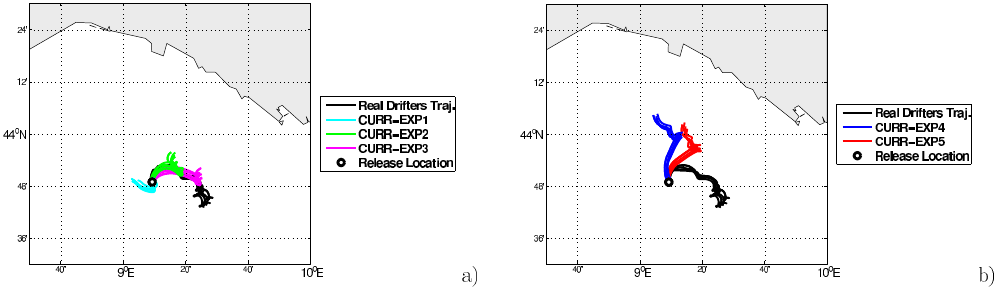
Fig. 2. Observed drifter trajectories (black lines) and the MEDSLIK-II trajectories from 14 May 2007 at 15:00UTC to 17 May 2007 at 15:00UTC. (a) The light blue lines are the trajectories obtained using the surface daily MFS currents (CURR-EXP1), the green lines are the trajectories obtained using the surface hourly MFS currents (CURR-EXP2) and the pink lines are the trajectories obtained using the surface hourly currents produced by the IRENOM (CURR-EXP3). (b) The dark blue lines are the trajectories obtained using the 30m hourly currents 14 produced by MFS and adding a 3% wind correction with a wind angle of 0 ◦ (CURR-EXP4) and the red lines are the trajectories obtained using the 30m hourly currents produced by MFS and adding a 3% wind correction with a wind angle of 25 ◦ (CURR-EXP5).